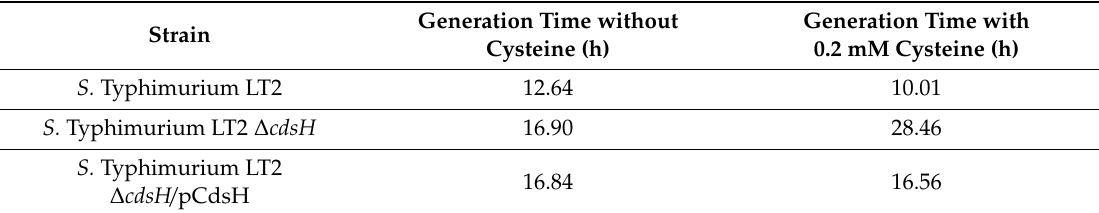
Table 4. Generation time at 24 h of the strains within the HT-29 line under normal conditions and with the addition of exogenous